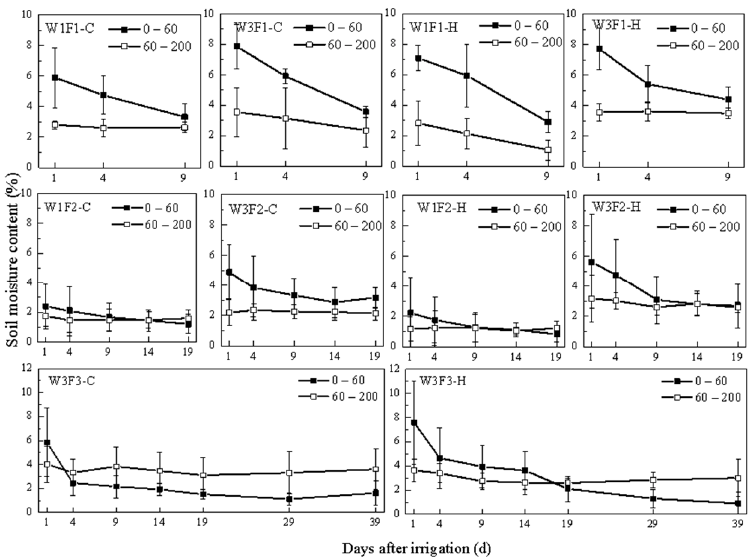
Figure 6. Variation in soil moisture content with the number of days after irrigation.